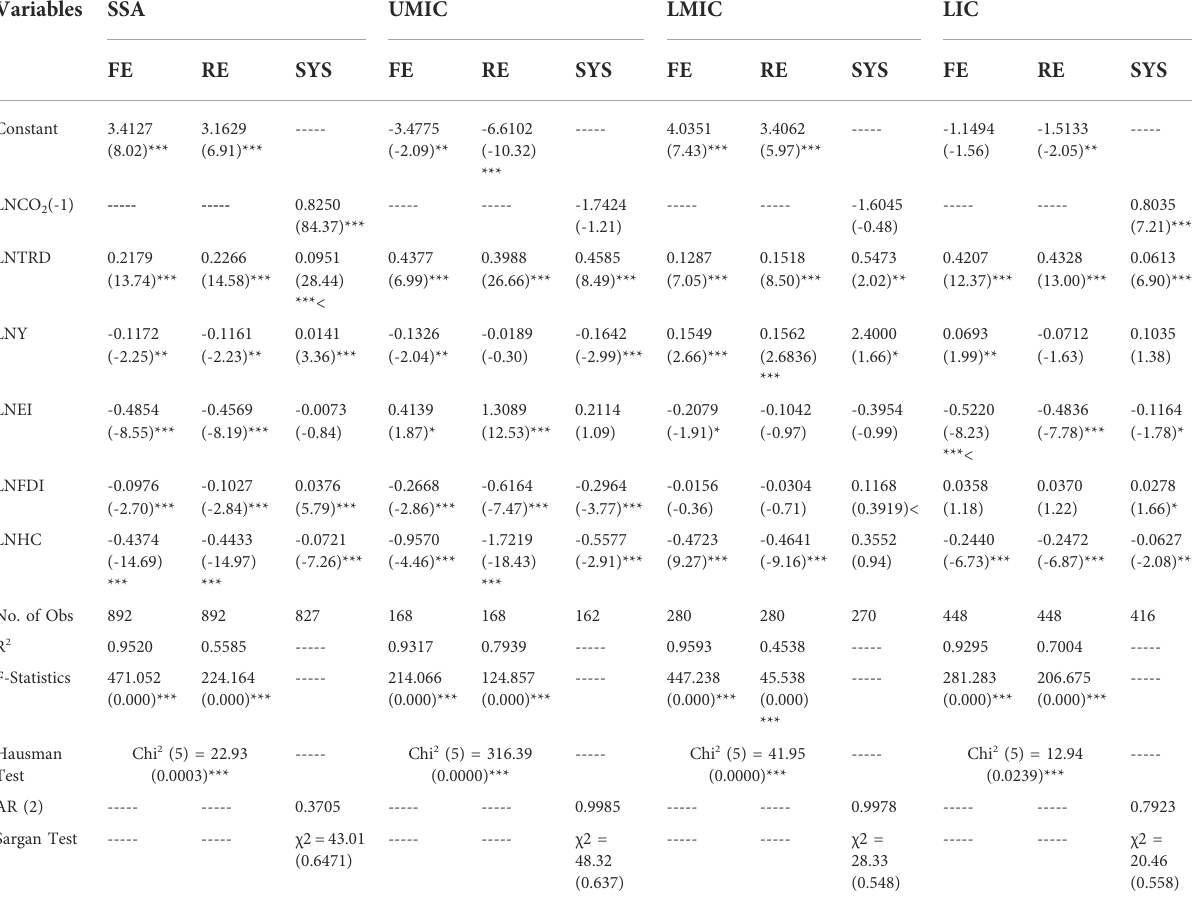
TABLE 3 Panel estimation results: LNCO 2 as the dependent variable.